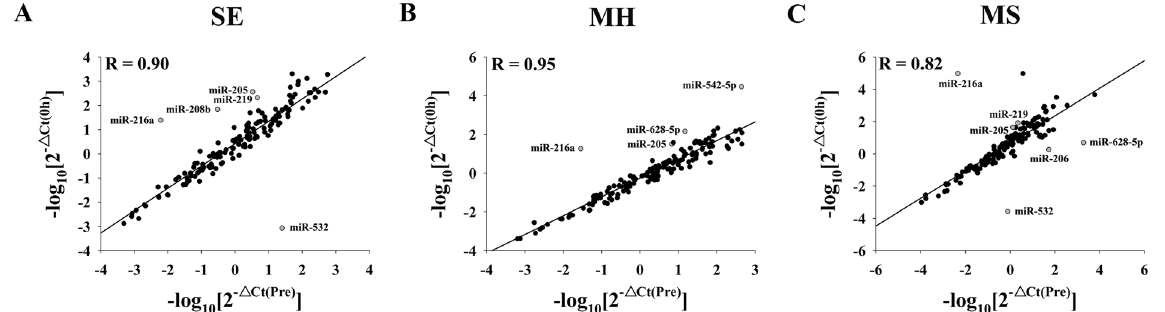
Figure 2. Pearson correlation scatter plot of the circulating miRNA levels for SE ( A ), MH ( B ) and MS ( C ) as determined by TLDA. The Ct values were normalized to the calculated mean Ct value of the Let-7d/g/i of each pooled sample ( Δ